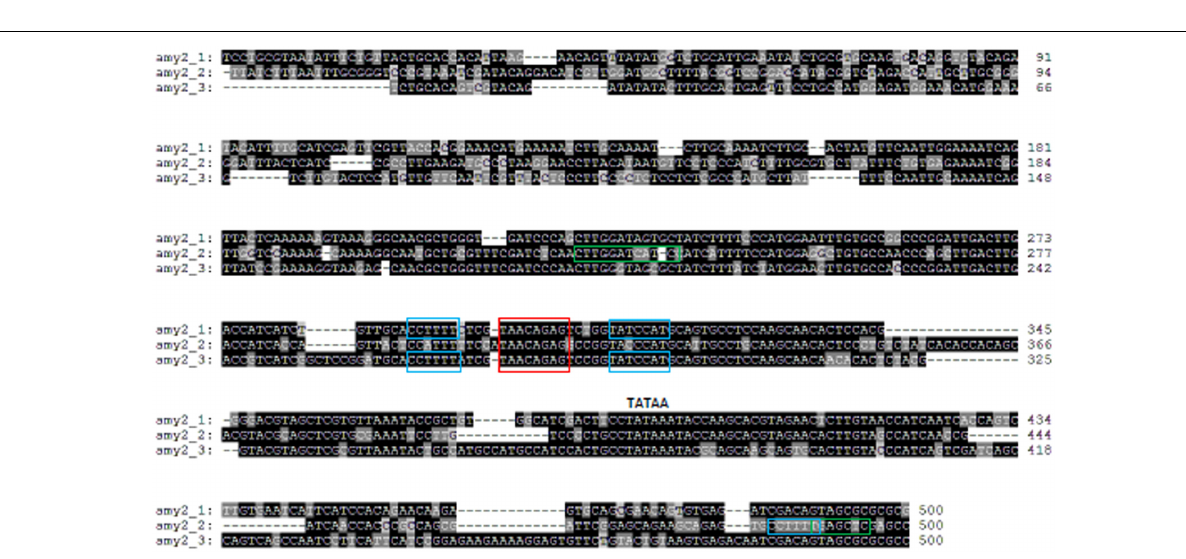
Frontiers in Plant Science |